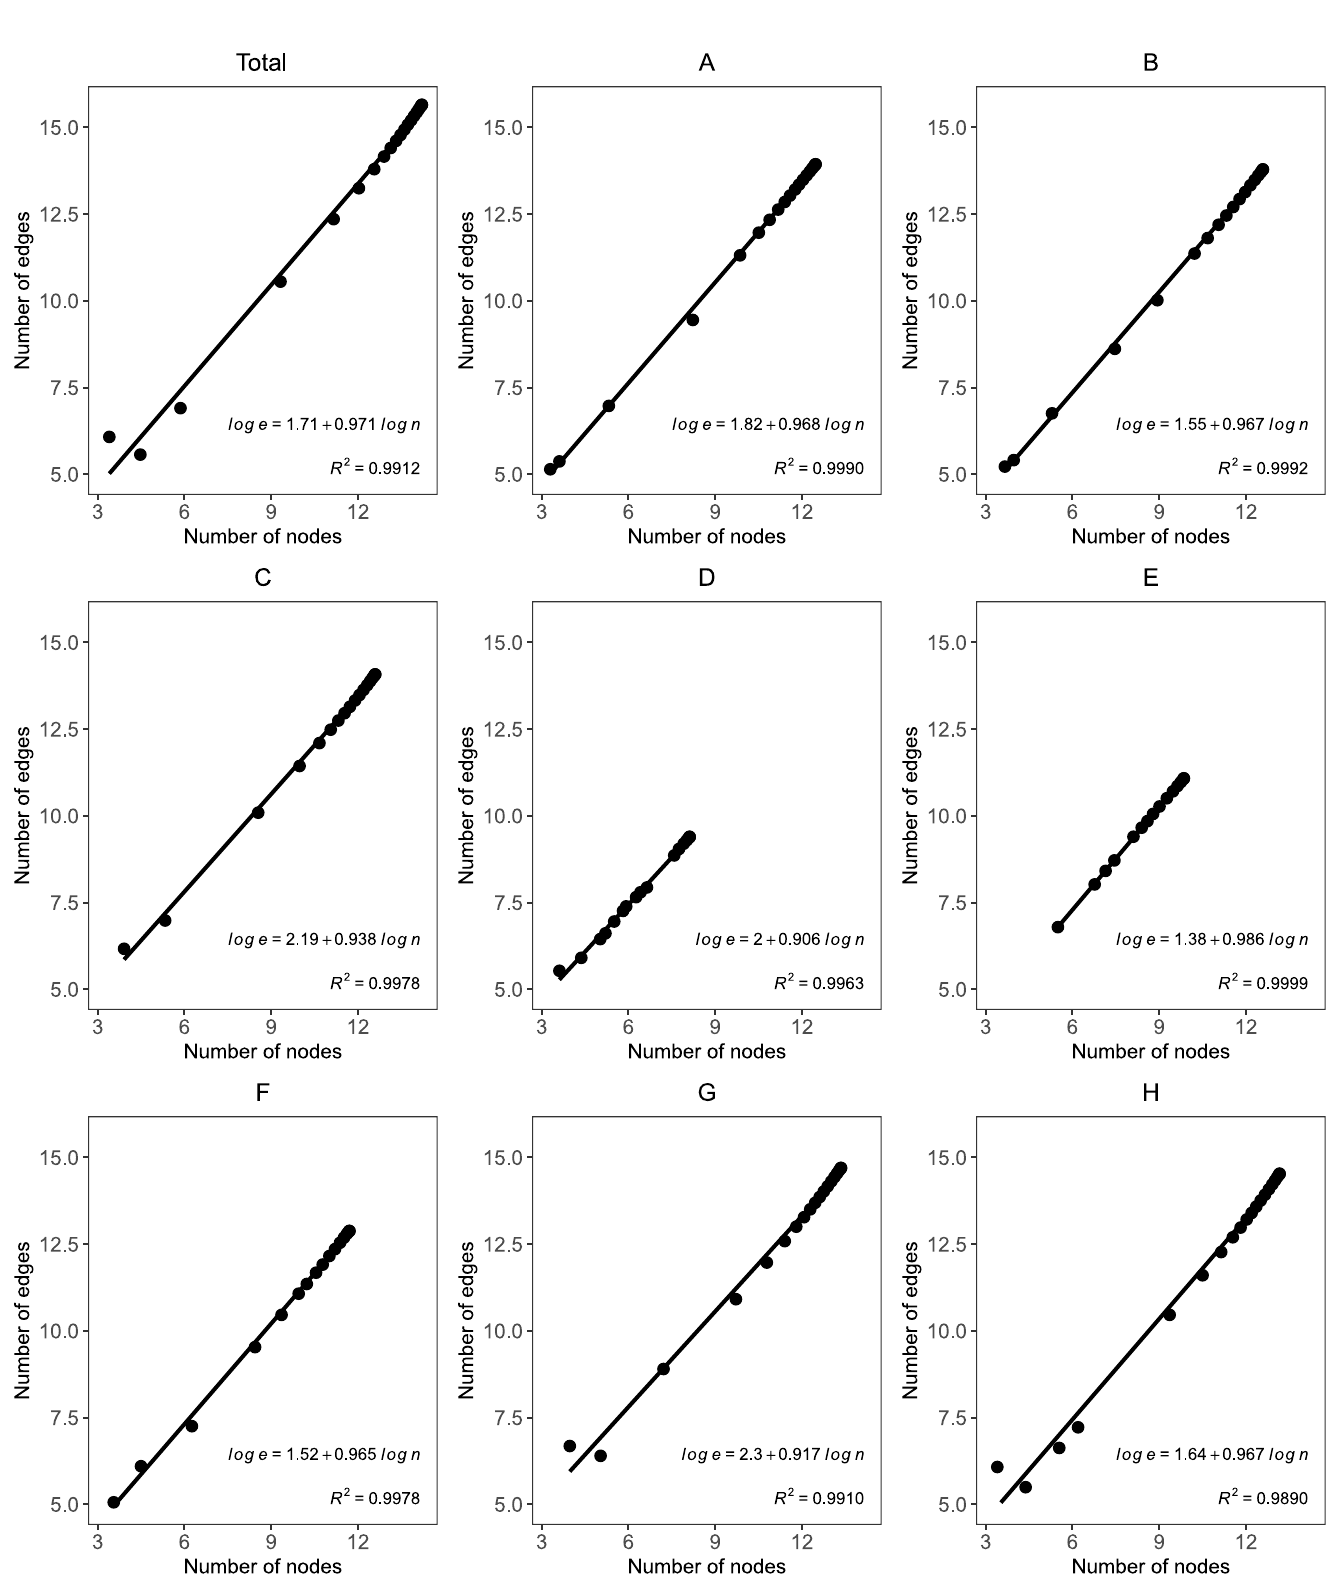
Fig 5. The number of nodes N(t) versus the number of edges E(t) in log-log scales by technological field, 1999–2019.